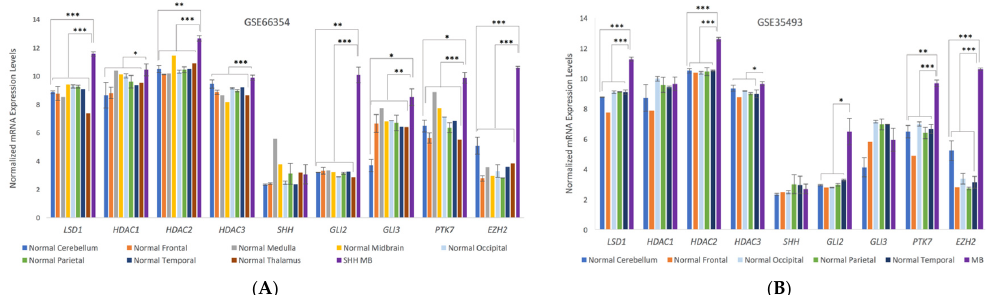
Figure 4. Normalized expression levels of key HDACs, SHH pathway genes, and other genes of interest in ( A ) human normal brain samples and SHH-MBs (GSE66354) based on microarray data from Griesinger et al. [11] or in ( B ) human normal brain samples and MBs of unspecified subtypes (GSE35493) based on microarray data from Birks et al. [12]. Error bars represent the standard error of the mean. Significance was tested across MBs ( n = 8 GSE66354, n = 17 GSE35493) versus normal cerebellum ( n = 2 GSE66354, n = 2 GSE35493) or all normal brain tissue ( n = 13 GSE66354, n = 9 GSE35493). p values were adjusted using the Benjamini and Hochberg procedure [14]; p < 0.001 (***), p < 0.01 (**), p < 0.1 (*).